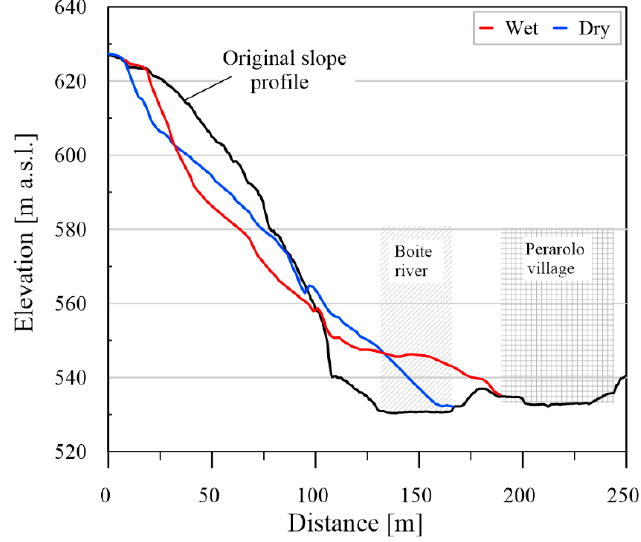
Figure 13. Height profiles of the sliding mass along cross-section C–C for the simulations in wet and dry conditions.